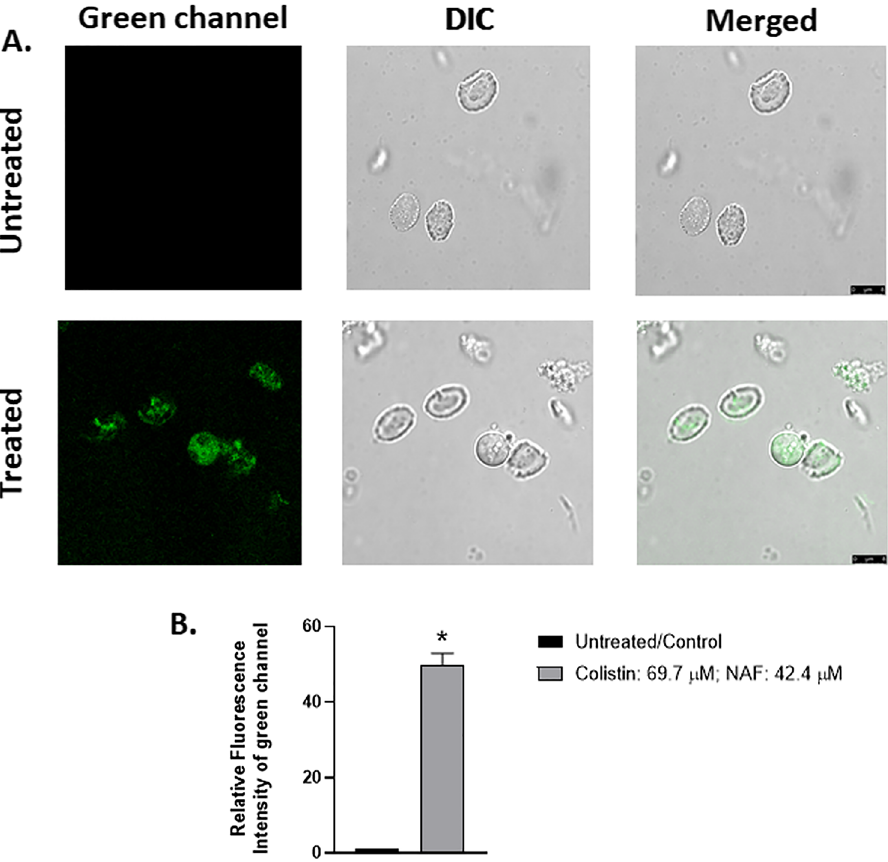
Figure 3. Confocal microscopic images of isolated hepatocytes from zebrafish ( A ) that were either left untreated (control) 42.4 µM of NAF for 45 min or treated with 69.7 µM of colistin and 42.4 µM of NAF for 75 and 45 min, respectively. Green channel, DIC images and merged images of untreated and treated cells are shown in consecutive rows. Scale bar is 8 μm. Zoom factor = 3.5. Magnification = ×630. ( B ) Relative fluorescence intensity of the above-mentioned images was quantified using ImageJ v 1.46 software and